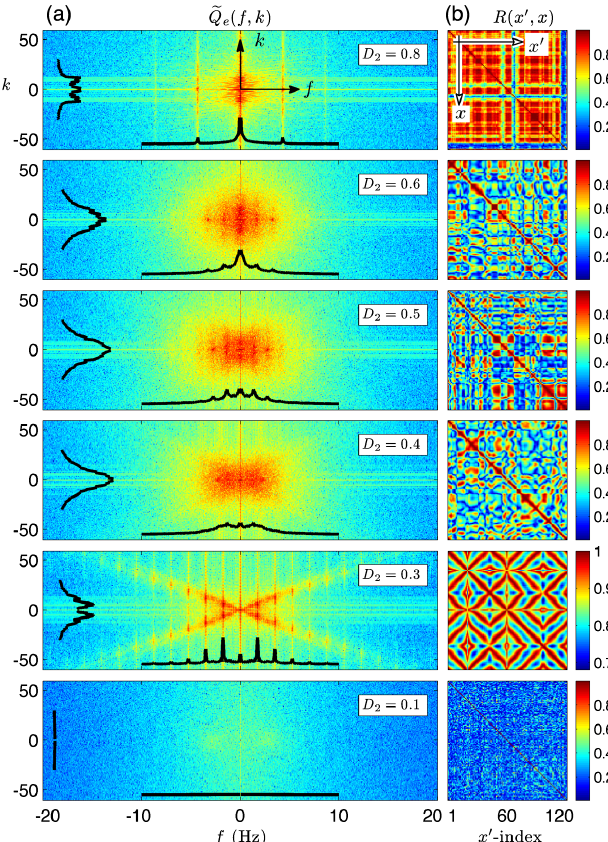
FIG. 9. Fourier spectra and phase coherence maps for the coma ~ Q f; k Þ shows the 2D discrete Fourier strip charts of Fig. 8. (a) e ð transform of Q e ð t; x Þ images of Fig. 8(b); f is the temporal frequency (Hz), and k is the spatial frequency (cycles =L x ). Inset line graphs in black compare the average temporal spec- ~ Q f Þ (horizontal format) against the average 1D spatial trum e ð ~ Q k Þ (vertical format). (b) Phase coherence maps spectrum e ð R ð x; x 0 Þ showing the degree of firing-rate coherence for time- series pairs Q e ð t; x Þ ; Q e ð t; x 0 Þ (with f x; x 0 g 2 f 1 ; 2 ; . . . 120 g ) along the y ¼ 60 midline; coherence maps are computed from the final 2 s of Fig. 8(b) strip charts. The color bar shows the mapping between color and phase